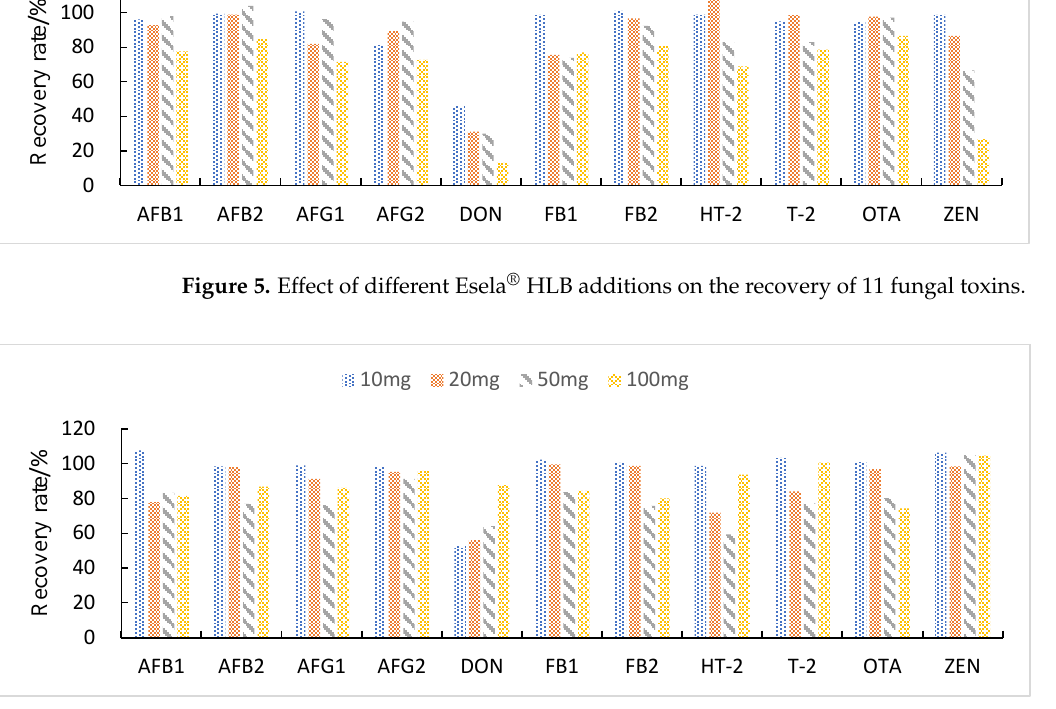
Figure 6. Effect of different Cleanert IC-H additions on the recovery of 11 fungal toxins.